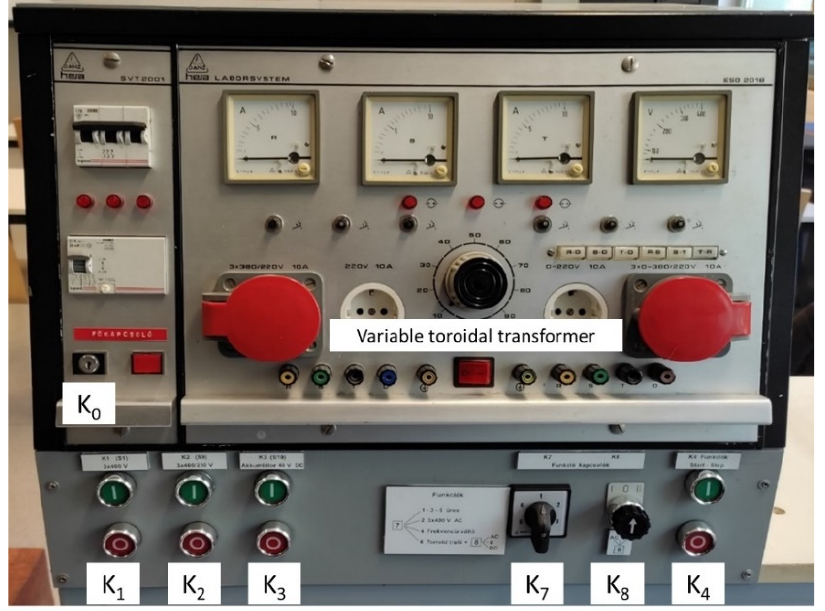
Figure 9. Labelled photo of the control desk (panel).